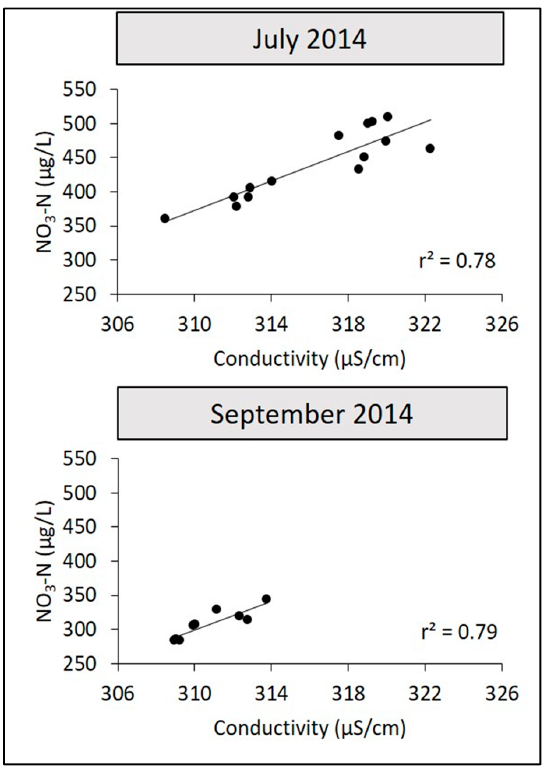
Figure 4. Comparison of transect means (see Figure 2 for transect locations) for NO 3 -N and specific conductivity in July and September 2014, respectively. The transect means are calculated as the mean of the vertically averaged concentration at each station within a